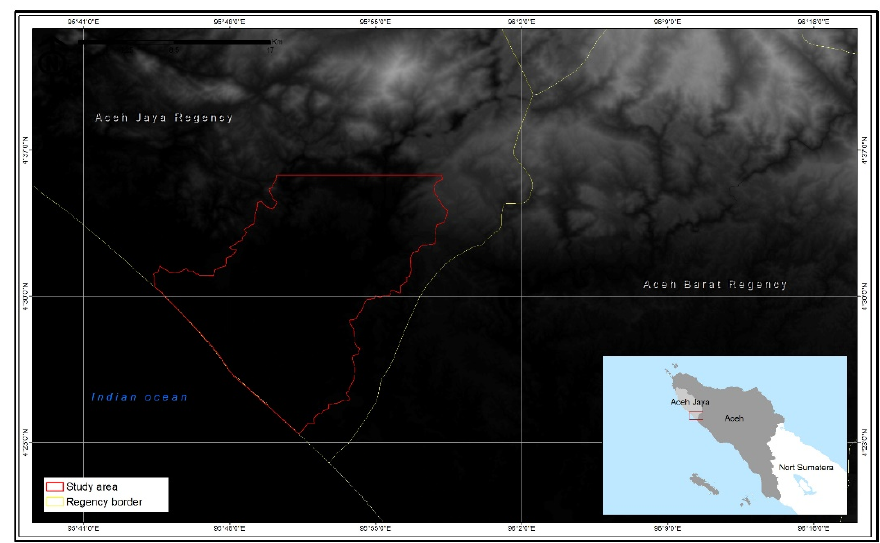
Figure 3. DEM of the study area and surroundings of Teunom watershed.